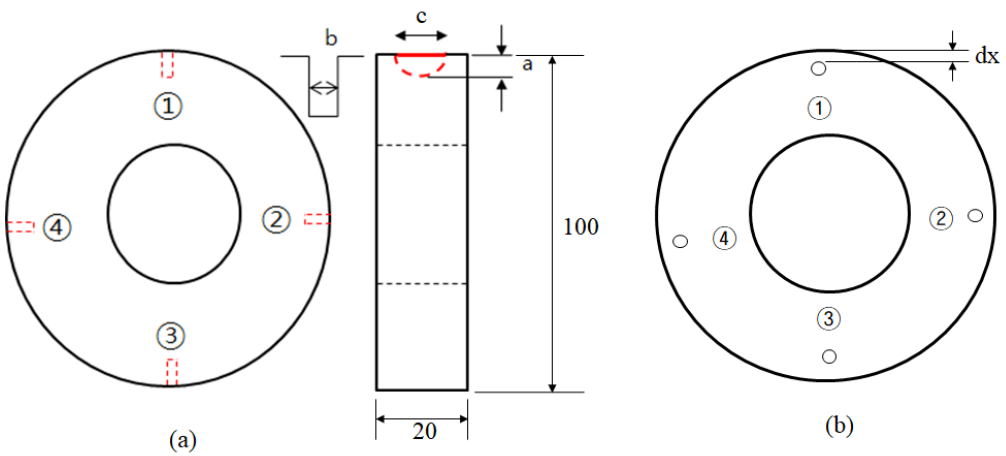
Figure 4. Geometry of specimens: ( a ) surface defect; ( b ) subsurface defect. Table 3. Mechanical properties of wheel specimens.